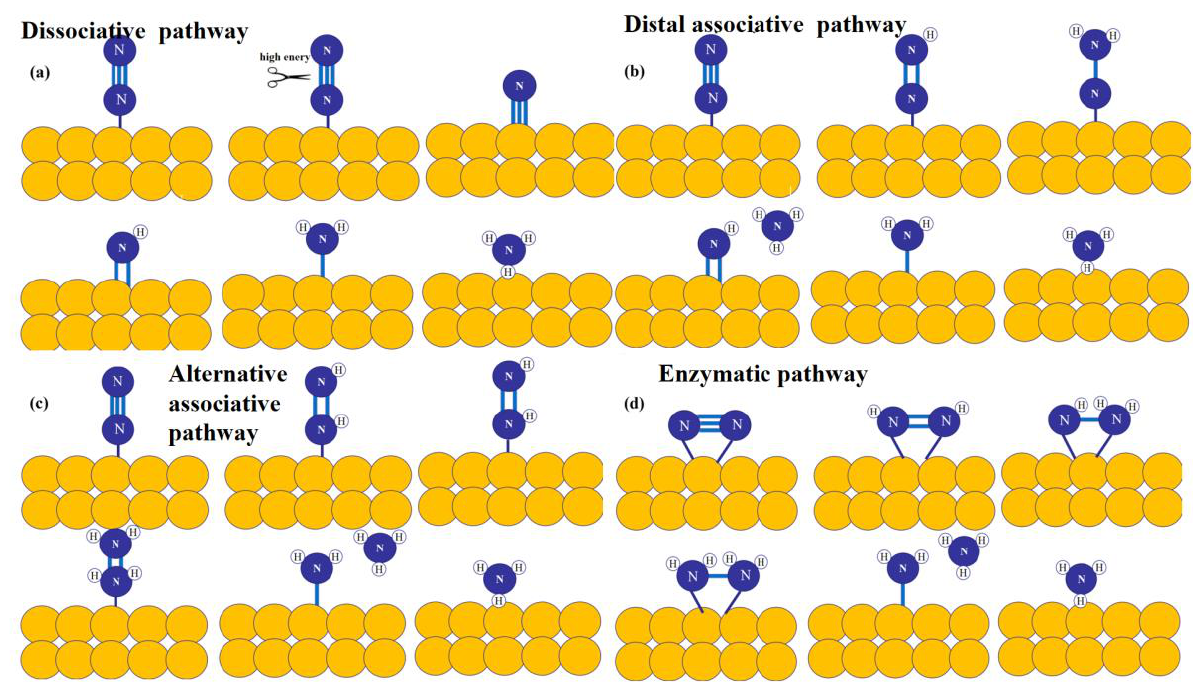
Figure 2. The mechanism of nitrogen fixation ( a ) dissociative, ( b ) distal associative, ( c ) alternative associative, ( d ) enzymatic.